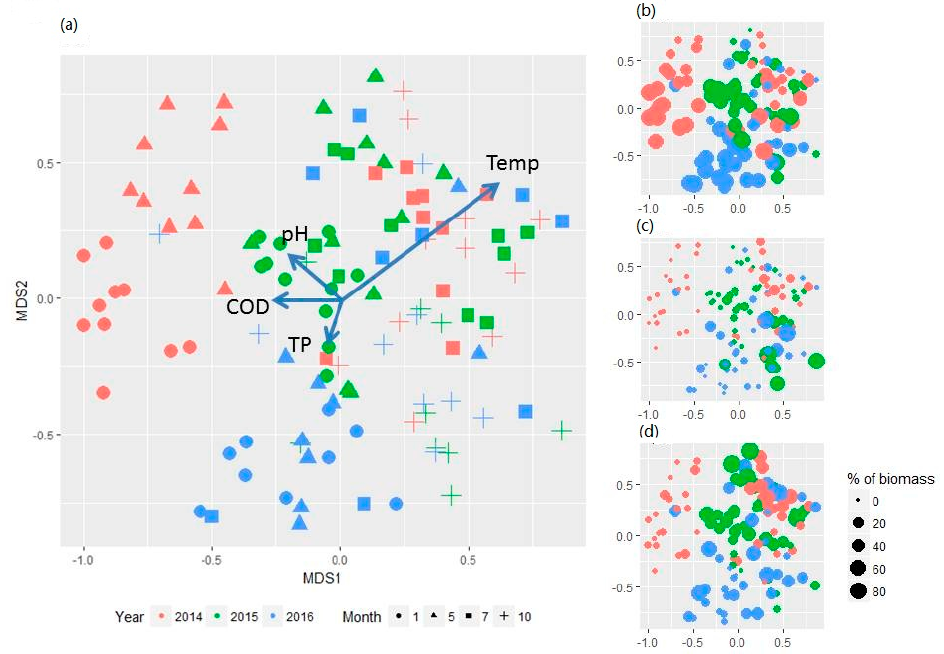
Figure 3. Site plot of non-metric multidimensional scaling (NMDS) analysis showing ( a ) temporal and spatial variation of phytoplankton assemblages between 2014 and 2016 in the Danjiangkou Reservoir with relation to major environmental variables; ( b – d ) the same plot superimposed with % of diatoms, cyanobacteria, and chlorophytes in each sample (bubble size is proportional to the relative abundance of total phytoplankton biomass).